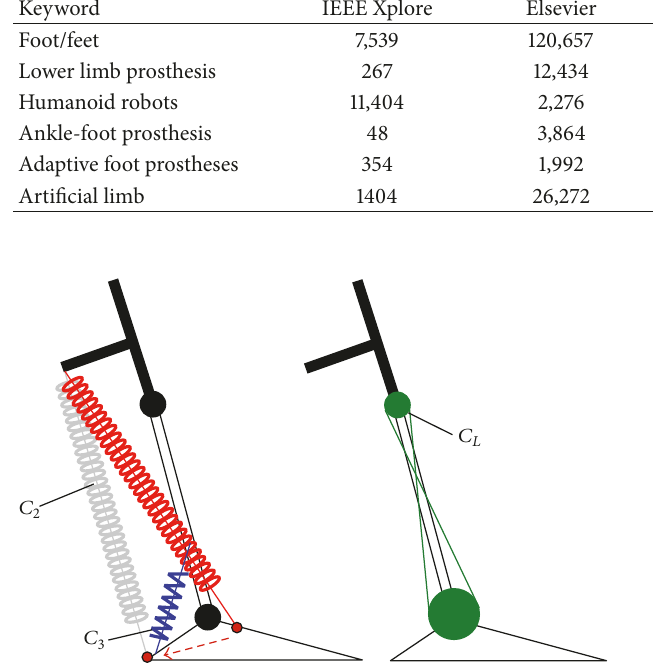
Figure 7: Spring arrangement of fully passive transfemoral prosthe- sis